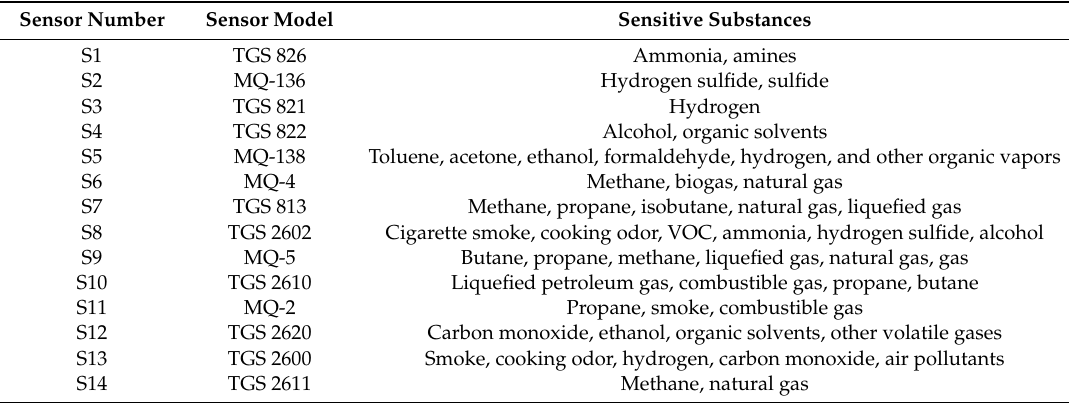
Figure 1. Schematic of the e-nose system. Table 1. Gas sensor array and its properties.